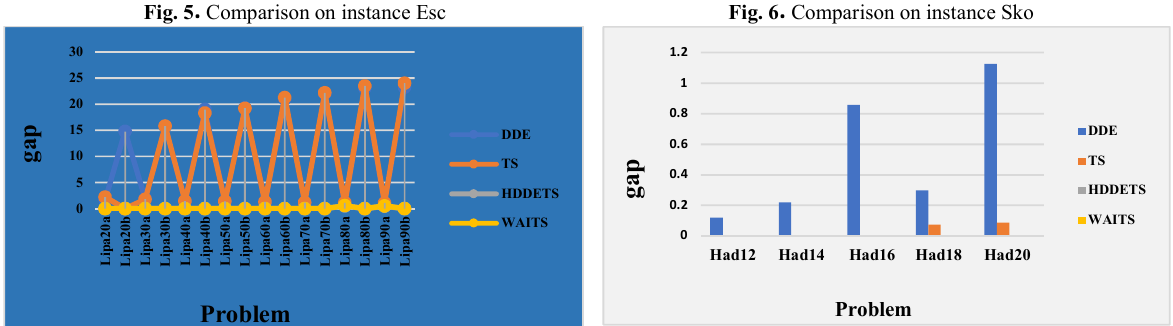
Fig. 5 . Comparison on instance Esc Fig. 6 . Comparison on instance Sko